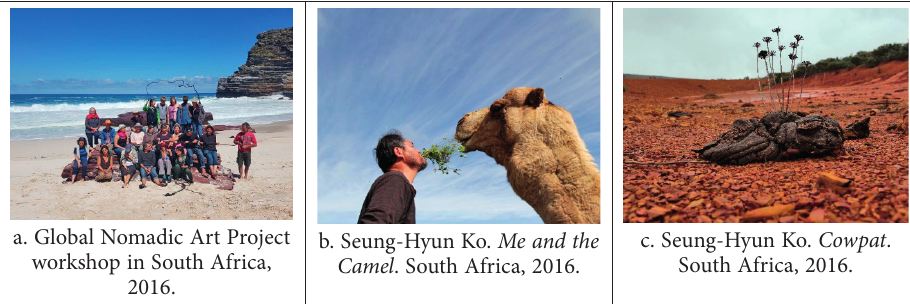
Table 4. Global nomadic art project activities in South Africa ( source: Courtesy of Yatoo )